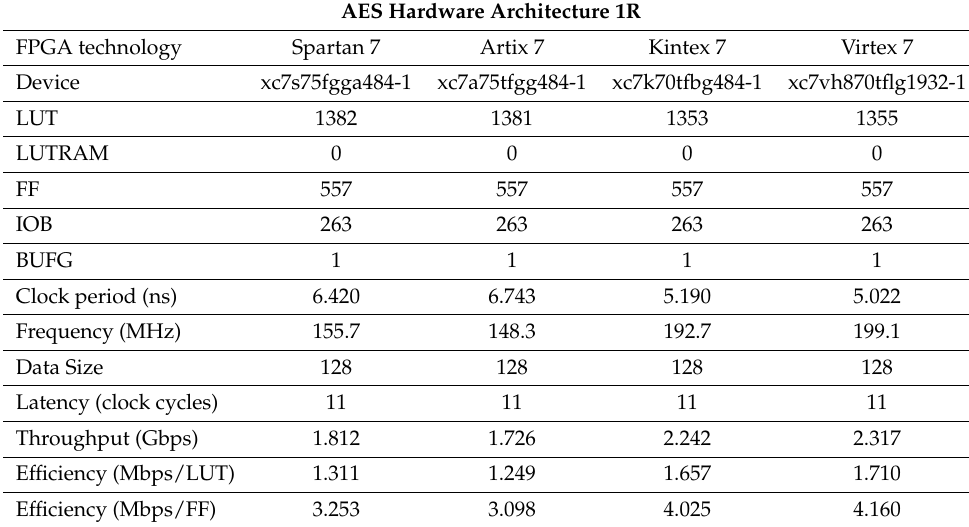
Table 3. AES hardware architecture